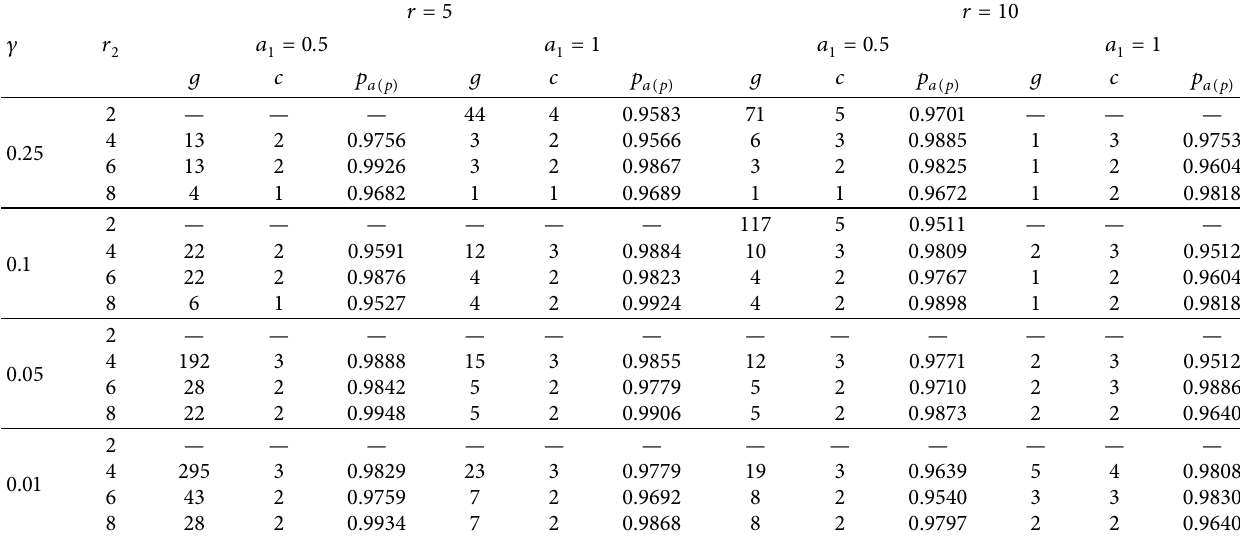
Table 4: GASP under the OPE model, showing minimum g and c when the ML estimates are considered: 􏽢 β � 0 . 5 and 􏽢 θ � 42. c r 2